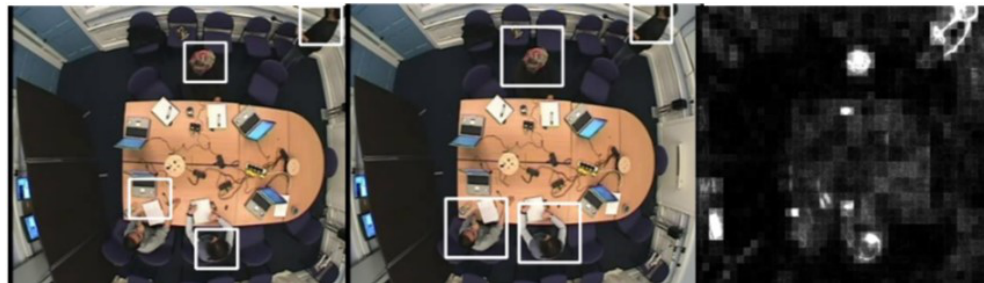
Figure 2. Examples of region of movement extraction with/without application of our motion coefficient (Frame 4921 of the ES2002a video from Augmented Multiparty Interaction (AMI) video data sets), where the first image is region of movement extraction without using motion, the second image is region of movement extraction based on coefficient of motion and the third image is accumulated frame differencing with window size = 100. Using this coefficient of motion reduces errors resulting from compression